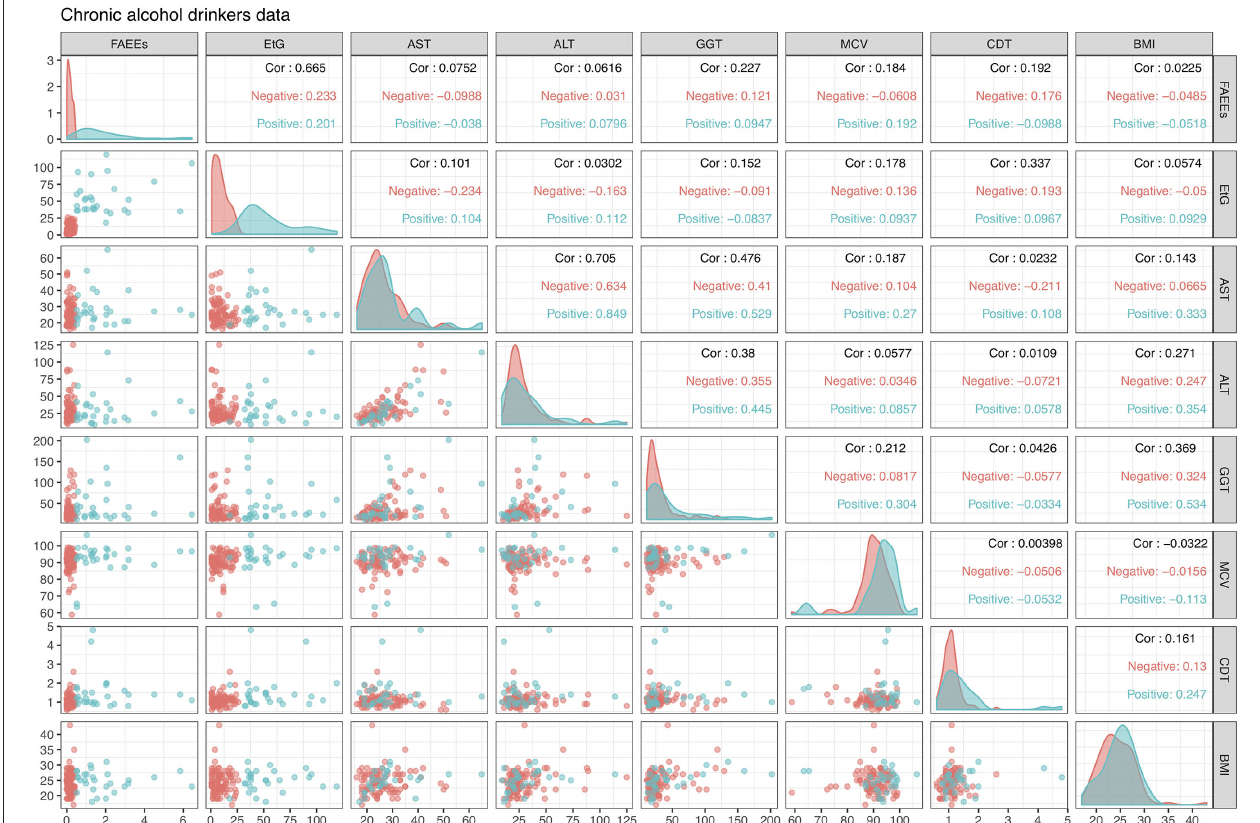
FIGURE 2 | Alcohol biomarkers dataset, with the color indicating the drinking status of the individuals: red is Negative (not chronic) and blue is Positive (chronic). The upper diagonal panels display the correlation of variables for the whole data but also separately for each class. Diagonal panels show densities of the data by class, while lower diagonal panels show bivariate scatterplots with points colored according to drinking status.